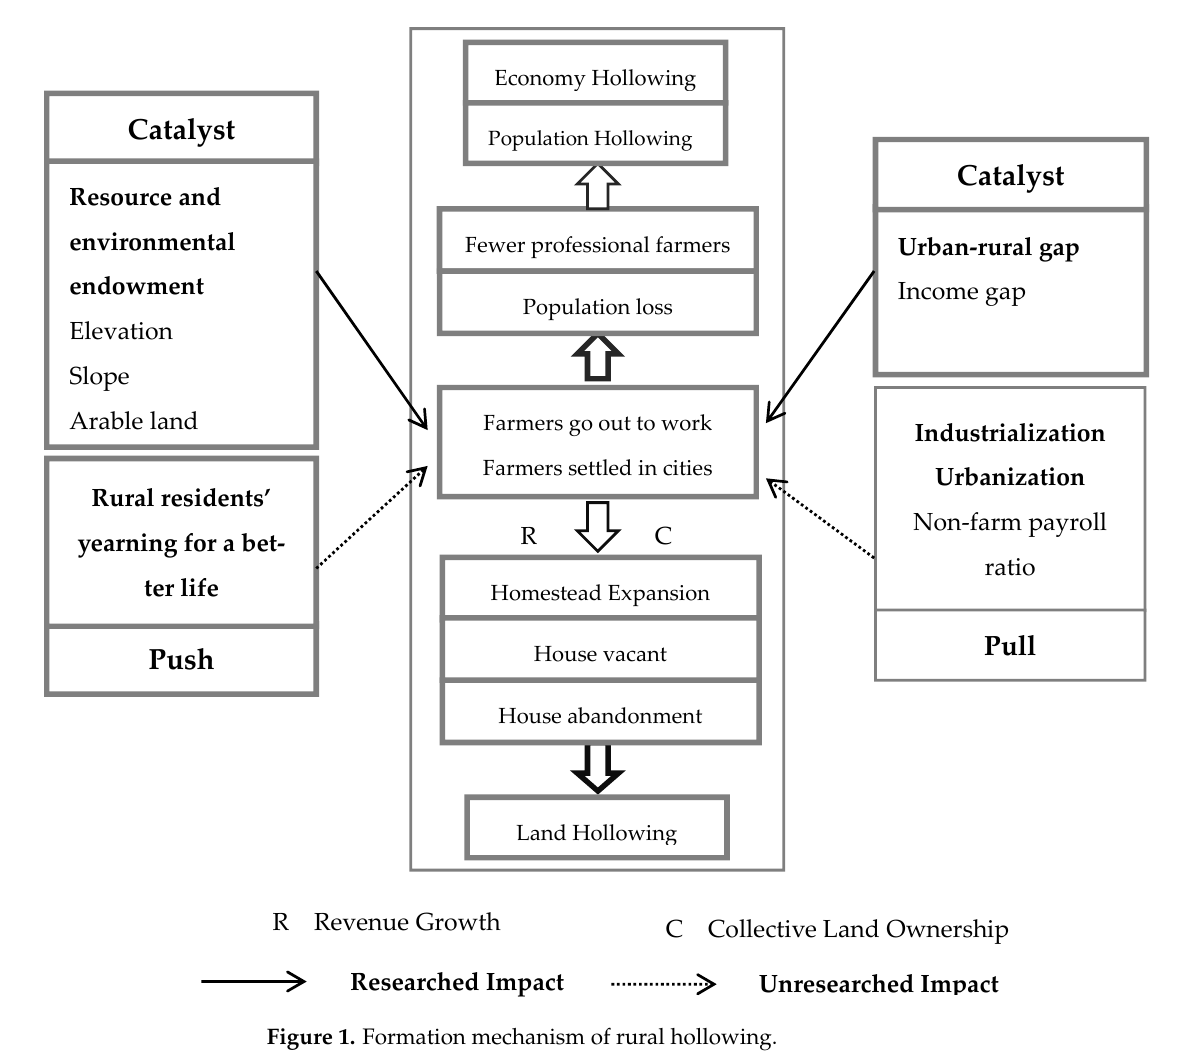
Figure 1. Formation mechanism of rural hollowing.